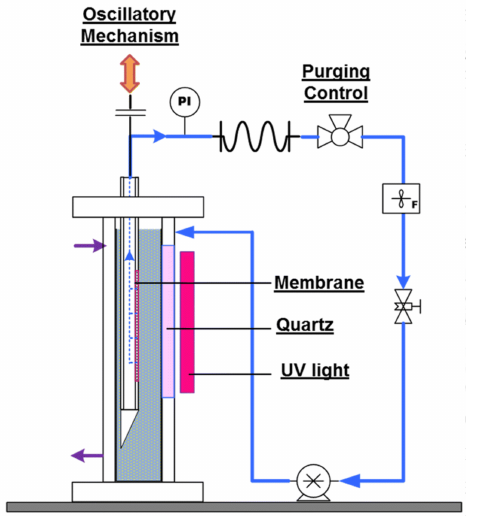
Figure 8. Schematic diagram of a submerged PMR for diclofenac removal from water [155].